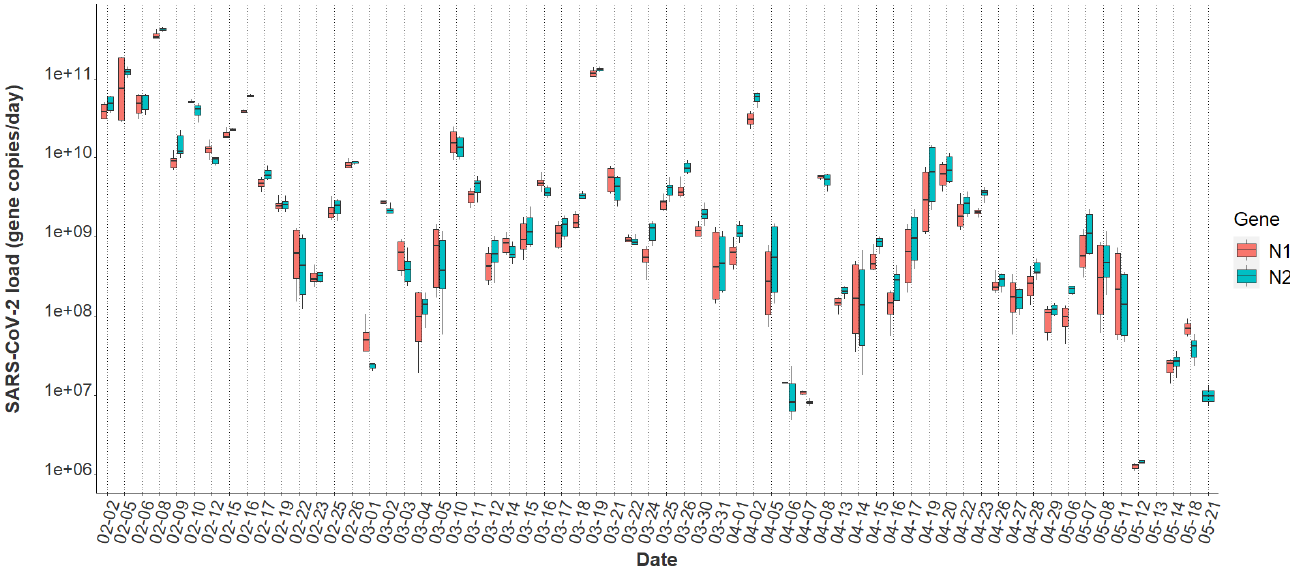
Figure 1. N1 and N2 daily viral loads from the COVID-19 isolation residence, 1 February 2021– 21 May 2021 (n = 64). Table 1. Quantification of viral loads and viral loads per person in the isolation residence.